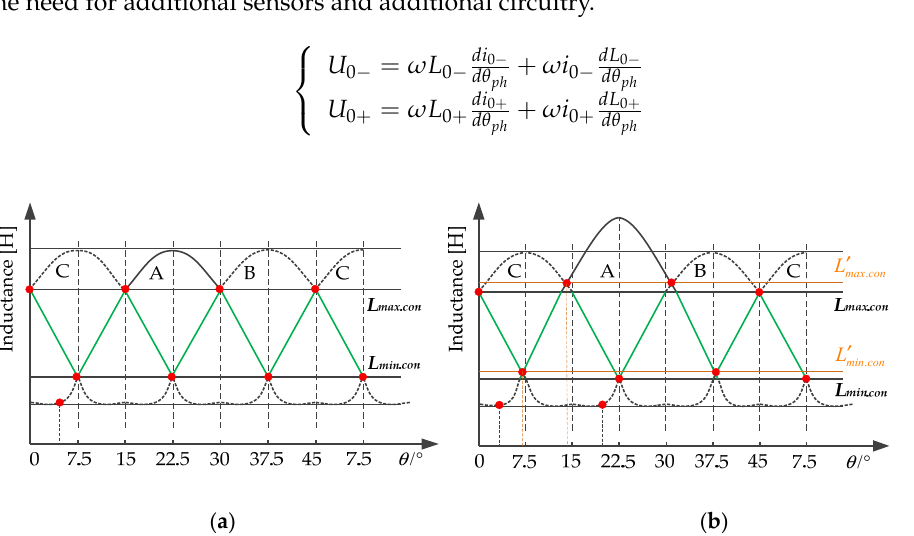
Figure 7. Phase inductance curve of a 12/8 three-phase SRM. ( a ) Balanced inductors. ( b ) unbalanced inductors.